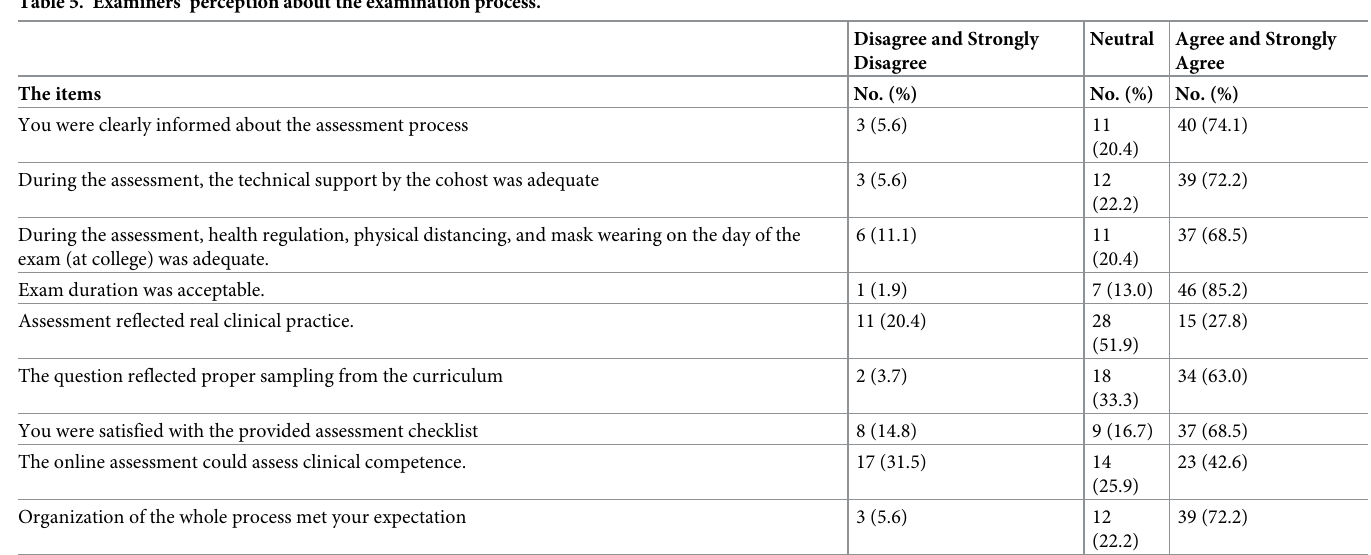
Table 5. Examiners’ perception about the examination process.